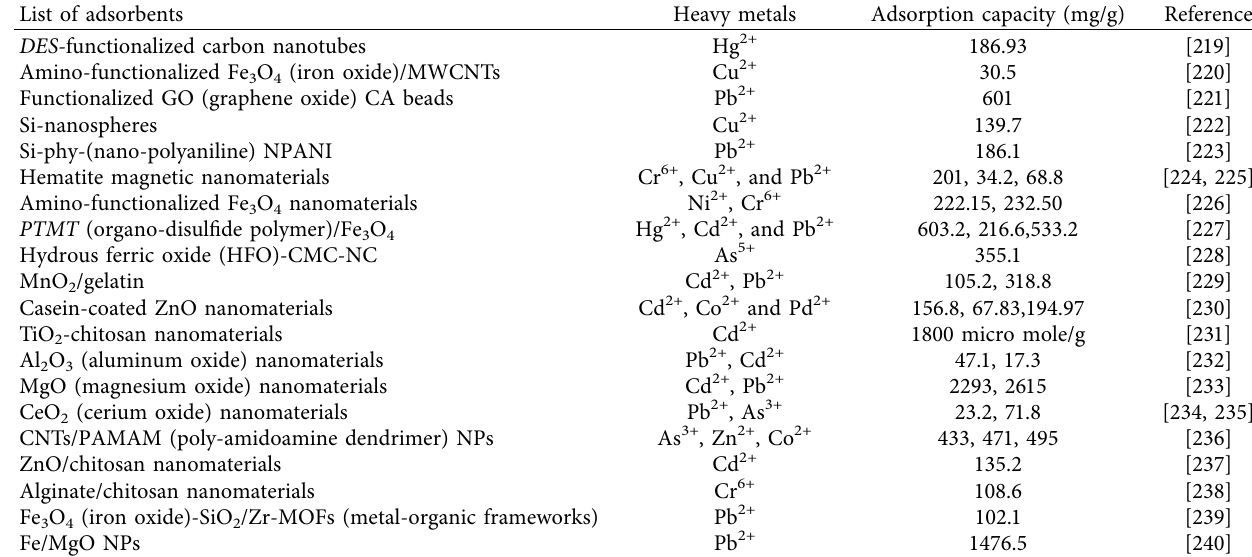
Table 4: Recent fndings of nanoparticles that makeover heavy metals.